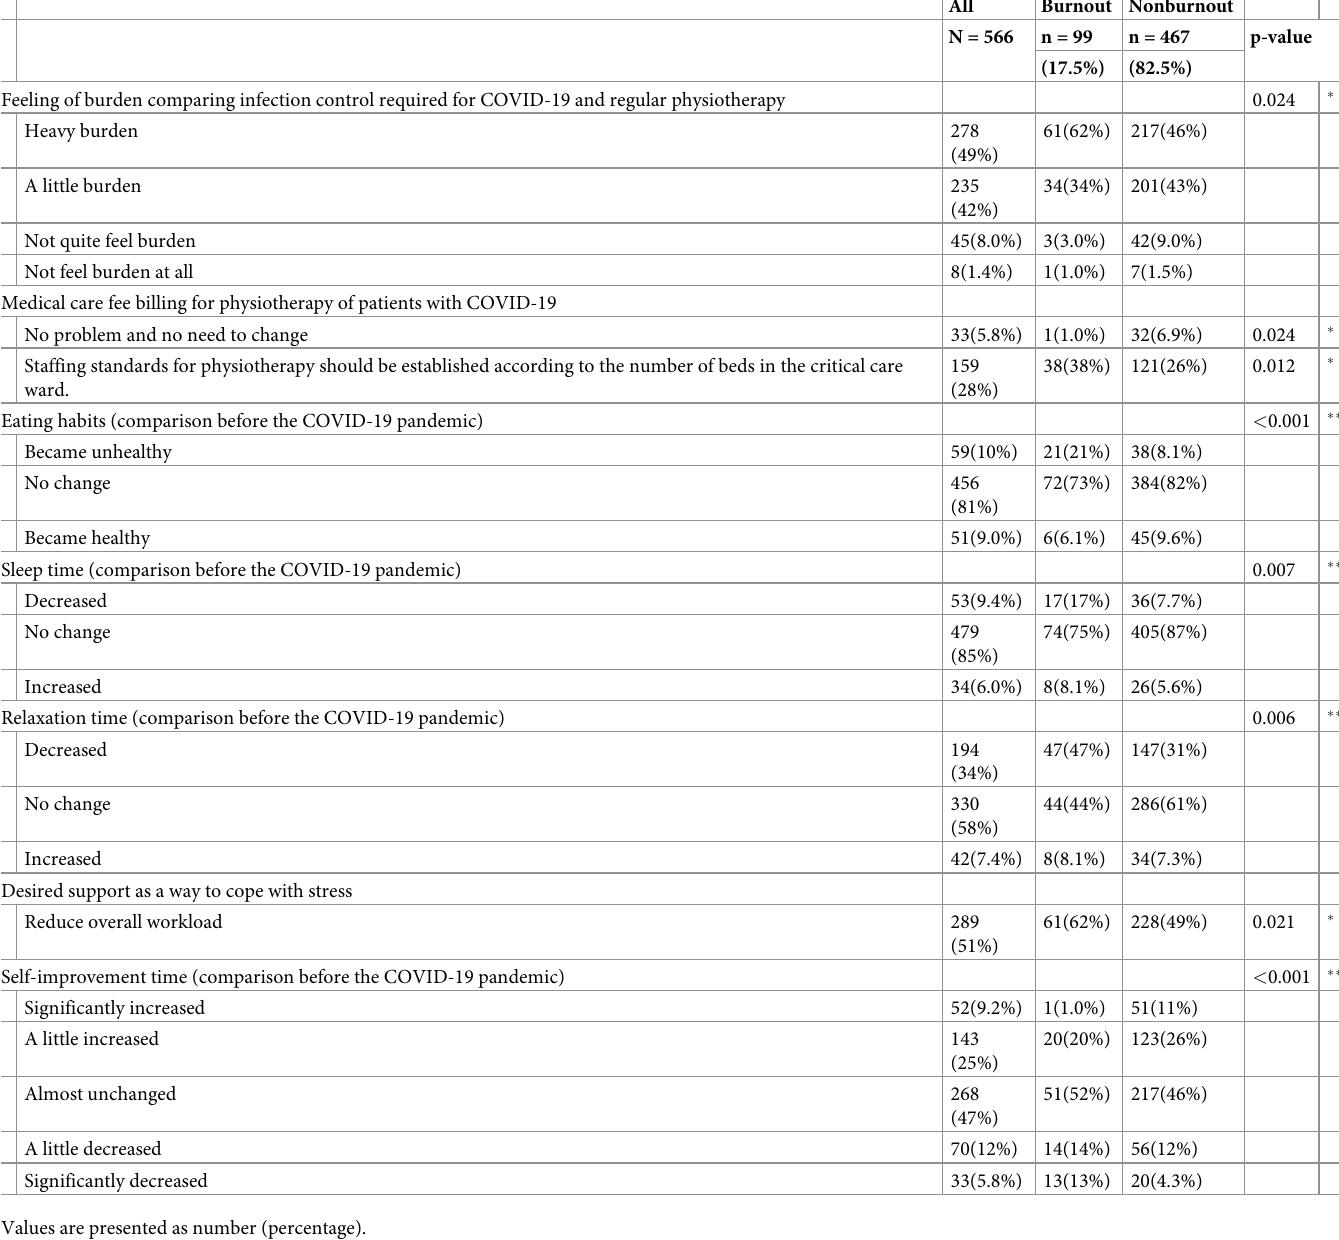
Table 2. Comparison of working environment between the burnout and nonburnout groups.